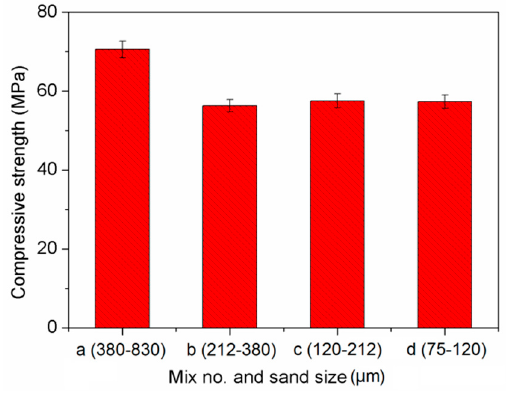
Figure 6 . Compressive strength of cement-based composites. Figure 6. Compressive strength of cement-based composites.